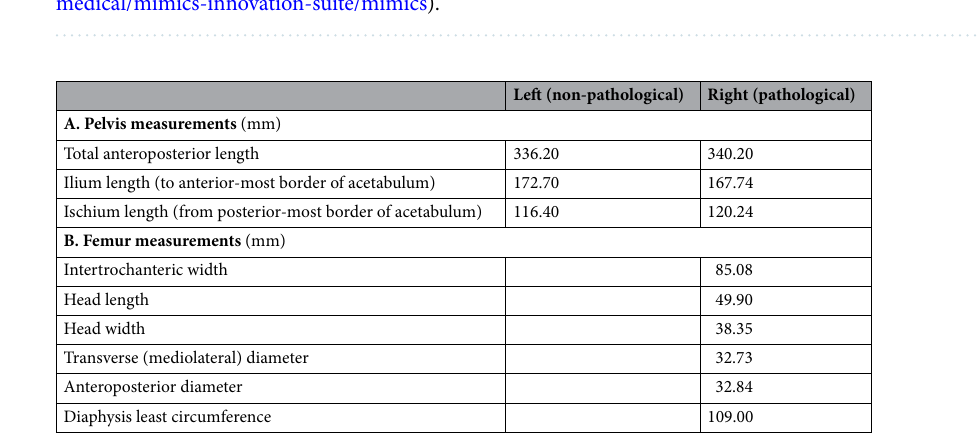
Table 1. Basic morphometric data for the two focal pathological Smilodon fatalis specimens: (A) pelvis, LACMHC 131; (B) right femur, LACMHC 6963. Morphometric data for comparative specimens are in Supplementary Data S4 and S5 and plotted in Figs. 6 and 7.